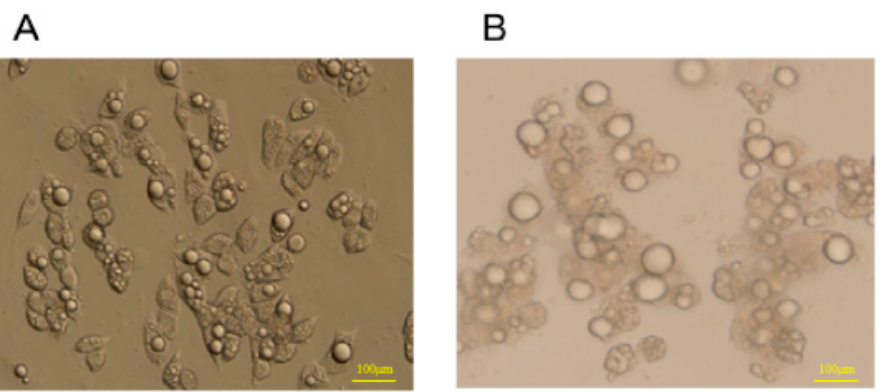
Figure 5. The comparison of the change of mature adipocytes before and after GSP treatment (fluorescent inverted microscope, 40 times). ( A ) Before GSP treatment. ( B ) After GSP treatment.